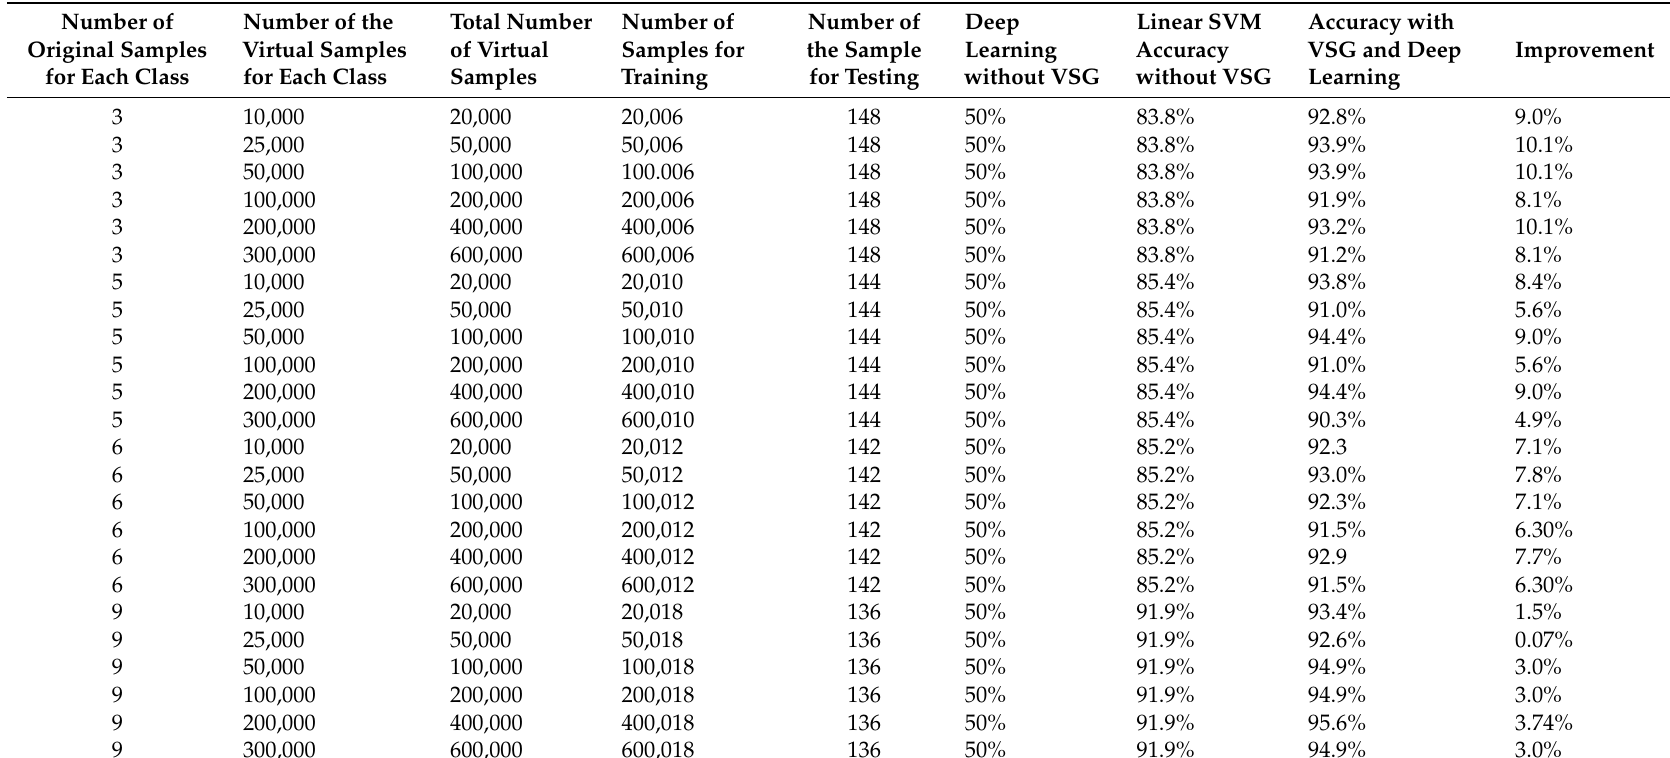
Table 3. The results of the average accuracy using the E. coli